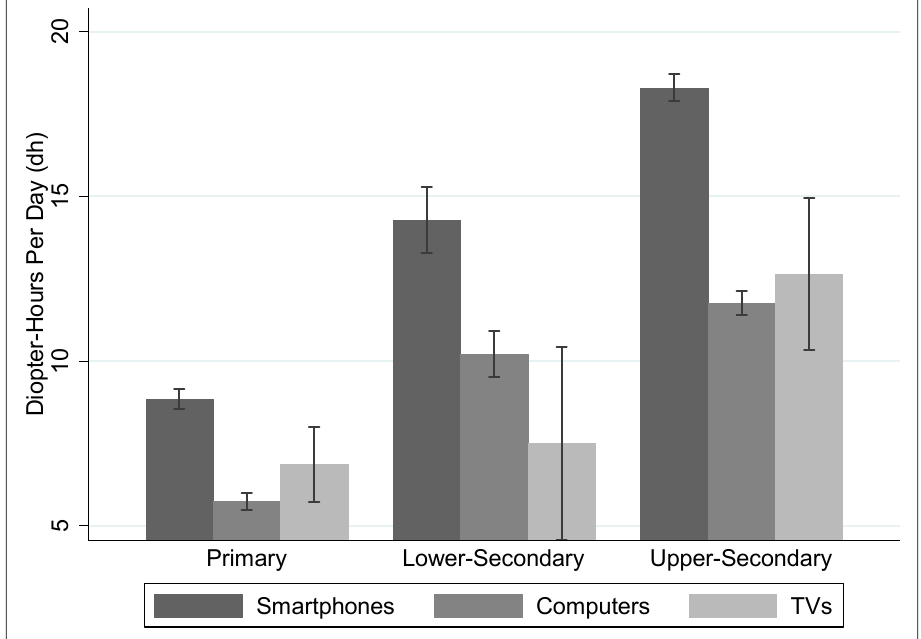
Figure 1. Daily use of e-learning devices among school-age children.